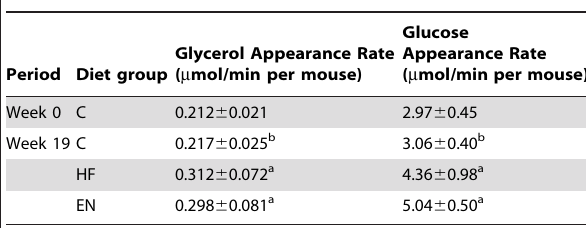
Table 4. Glycerol and glucose turnover